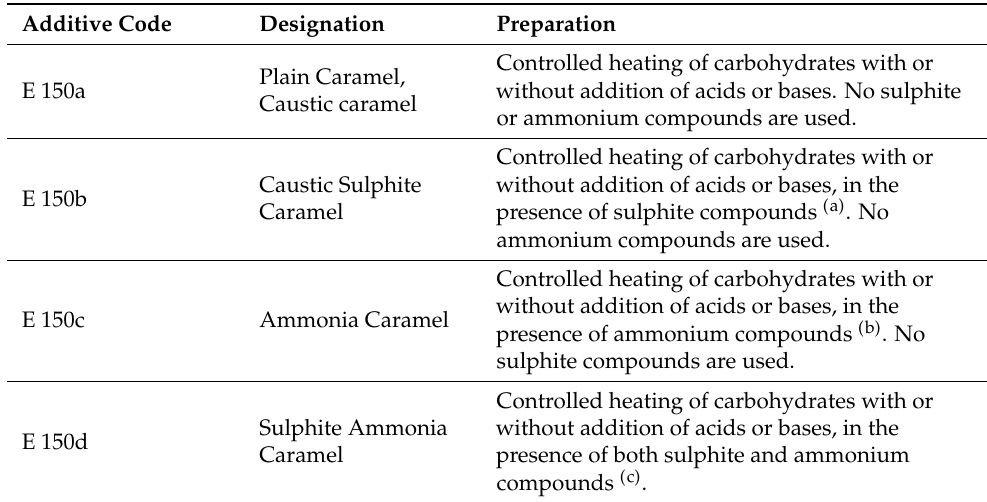
Table 2. Caramels used as the food colour E150 and their preparation. Additive